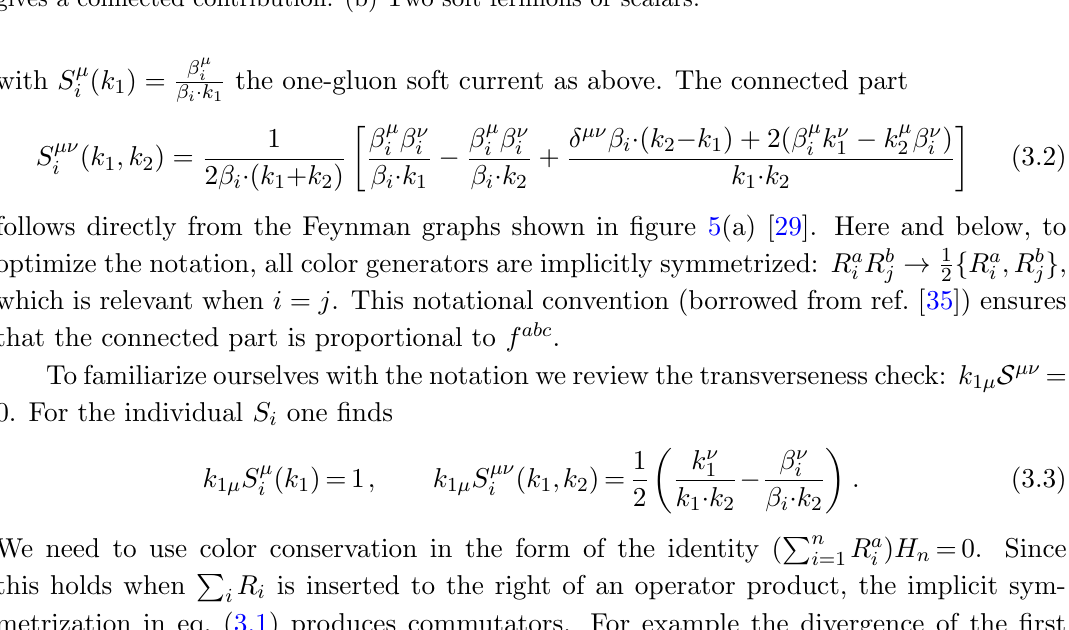
Figure 5 . Building block for next-to-leading order computation: amplitude for two soft particles. Solid lines are eikonal Wilson lines. (a) Two soft gluons. The non-abelian part of the (cid:12)rst graph gives a connected contribution. (b) Two soft fermions or